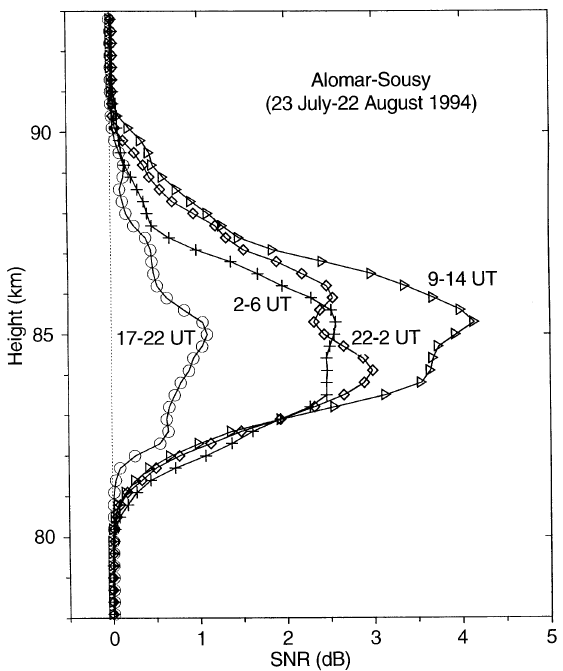
Fig. 2. Mean profiles of the SNR obtained by ALOMAR SOUSY radar observations for different time-intervals during the day h (EISCAT) " h (ALOMAR SOUSY) # 0.4 km. The cor- responding correlation coefficients using hourly SNR values with these slightly different height-intervals are presented in Fig. 4 by crosses connected with dashed